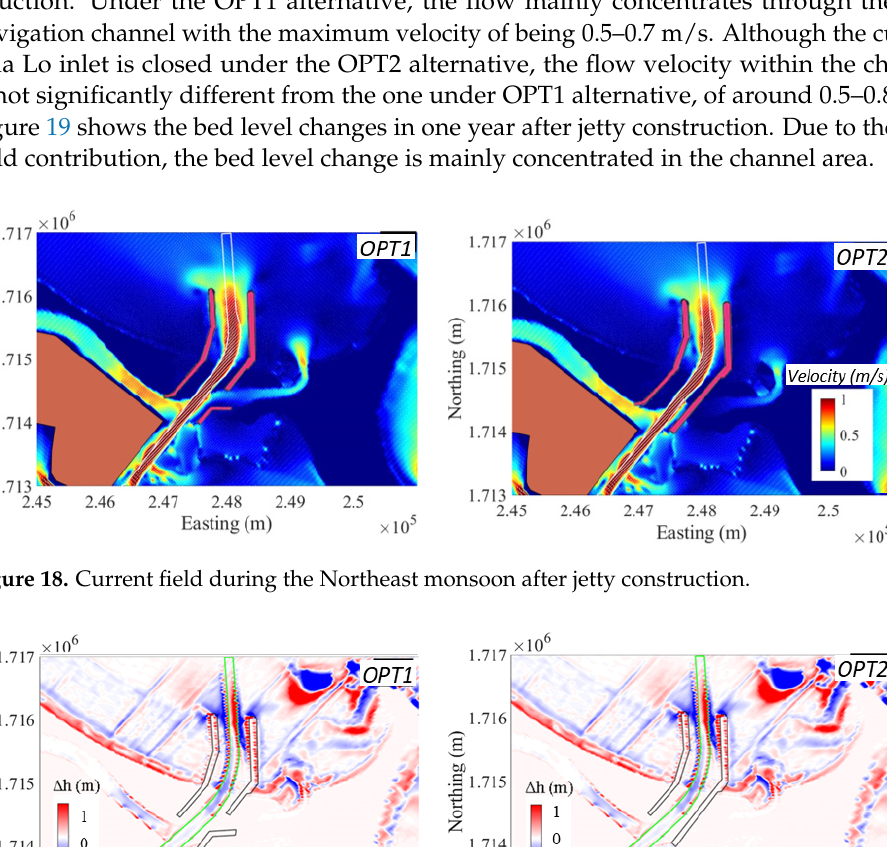
Figure 20. Wave field during typhoon Molave after jetty construction. Figure 21 illustrates the velocity field during typhoon Molave after jetty construction. The flow is larger within the estuary and port area, with a velocity of 0.5–2.0 m/s in the new channel. The flow in OPT2 alternative is slightly higher than the one in OPT1 alter- native.